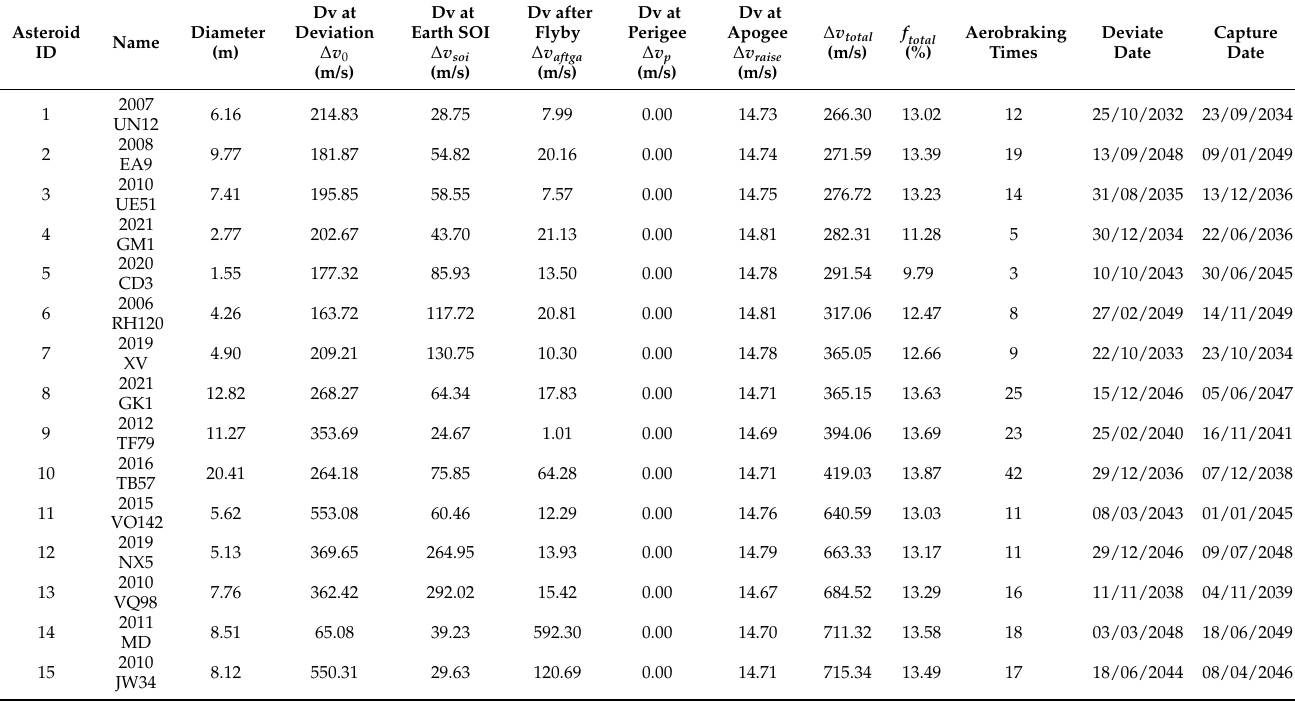
Table 4. Otimization results of using lunar flyby plus Earth aerobraking strategy.